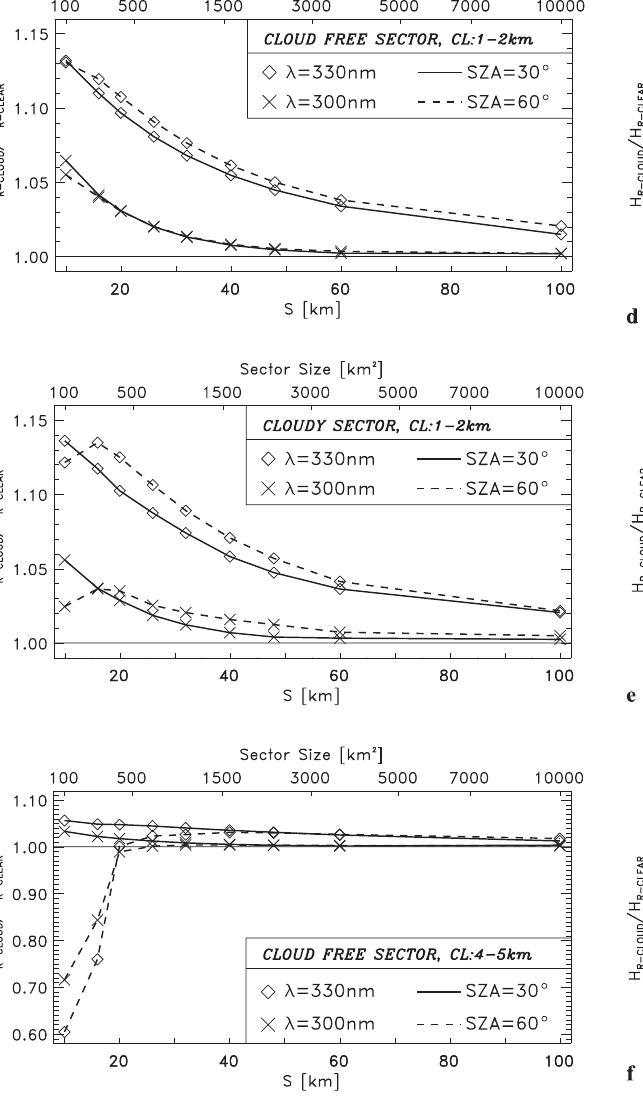
Fig. 3a–f. Ratio of surface irradiances at sector center calculated with (cid:133) H R (cid:255) Cloud (cid:134) and without (cid:133) H R (cid:255) Clear (cid:134) remote clouds as a function of S and of sector base size. This ratio is used to quantify the RCE. Calculations are performed for homogeneously cloud-filled as well as for cloud-free sectors taking into account two SZA (30 (cid:14) , 60 (cid:14) ) and two wavelengths (300 nm, 330 nm). Clouds in and outside the sector are